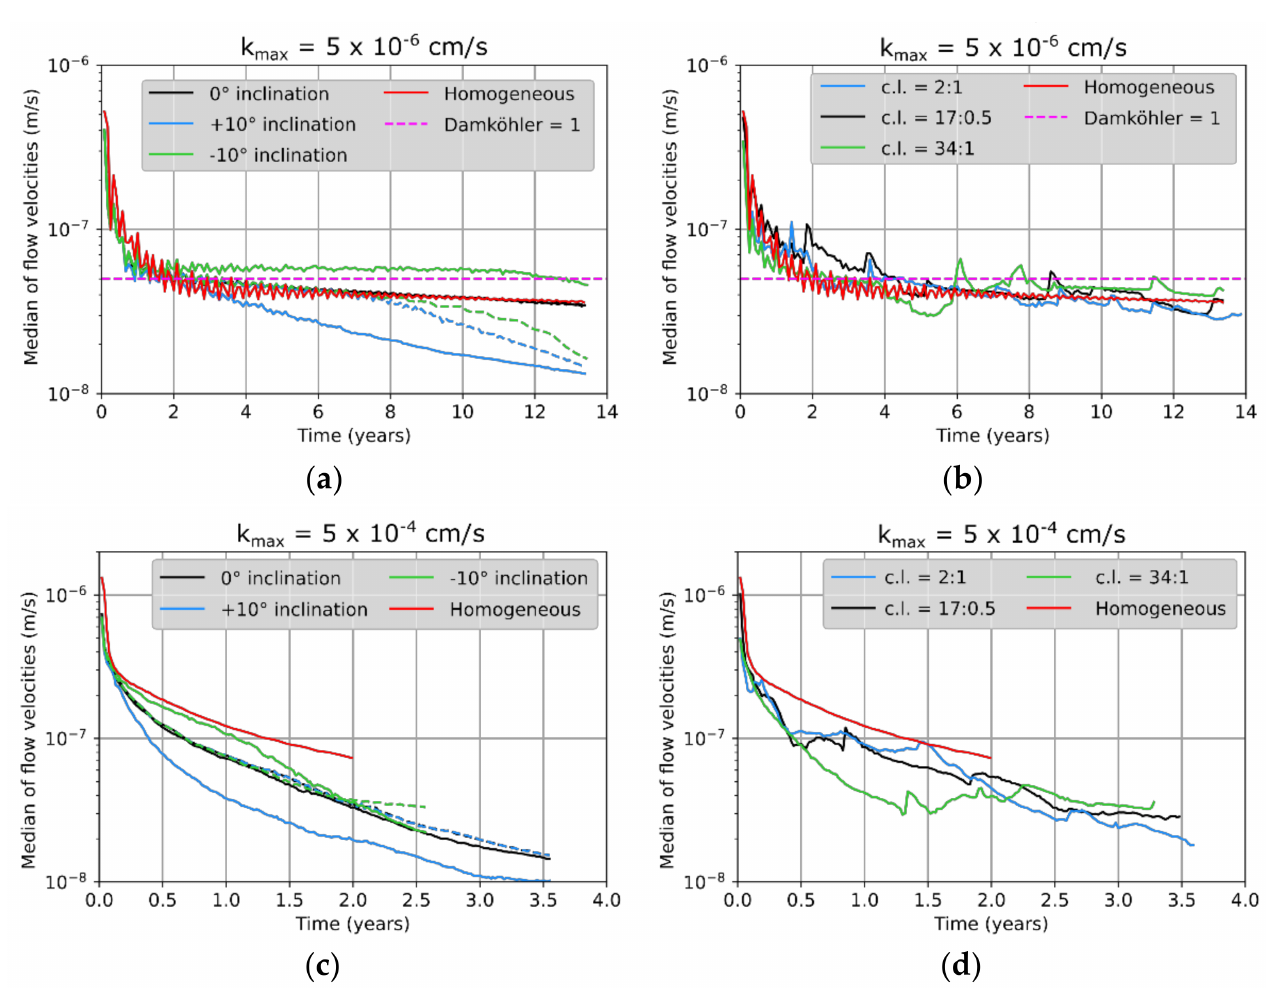
Figure 8. Median of flow velocities over time for ( a , c ) an intersecting halite layer (solid line, below layer; dotted line, above layer) and ( b , d ) halite inclusions (c.l., correlation length) compared to the homogeneous